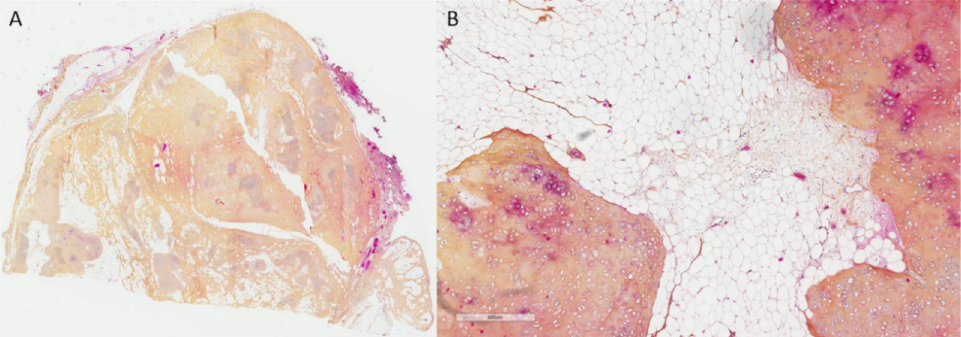
Figure 3. ( A ). Original × 25. At low magnification, lobules of cartilaginous tissue intermingled by fibrovascular and adipose tissue. ( B ). Original × 100. Lobules of mature cartilage with cytologically bland cells and deep clefts lined by bronchiolar type epithelium.